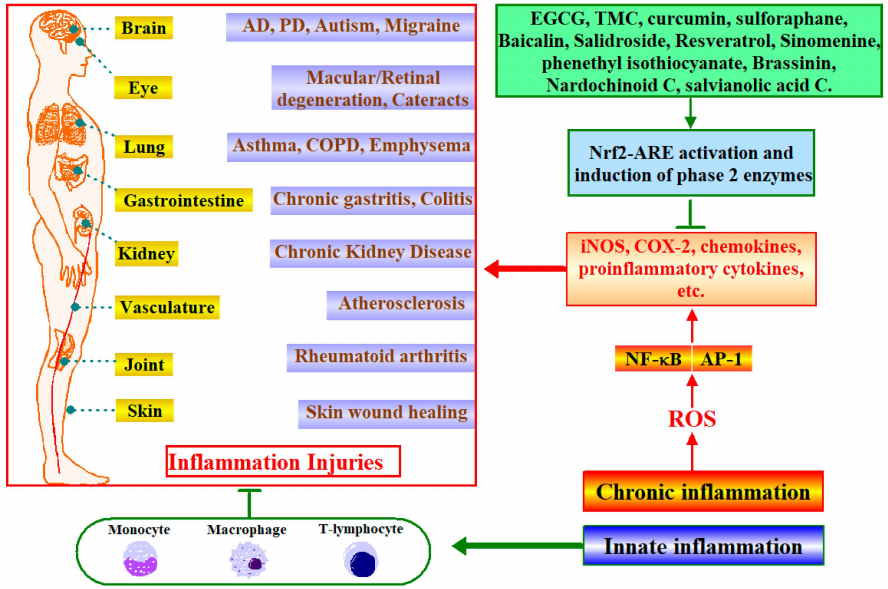
Figure 5. Phytochemicals target Nrf2 for inflammatory diseases intervention. Chronic inflammation produces ROS, which leads to the release of more inflammatory cytokines and inflammatory damage in various tissues and organs. A large number of studies have shown that phytochemicals can activate Nrf2-ARE signaling pathway and induce phase II enzymes, thereby inhibiting the expression of pro-inflammatory factors and preventing inflammatory